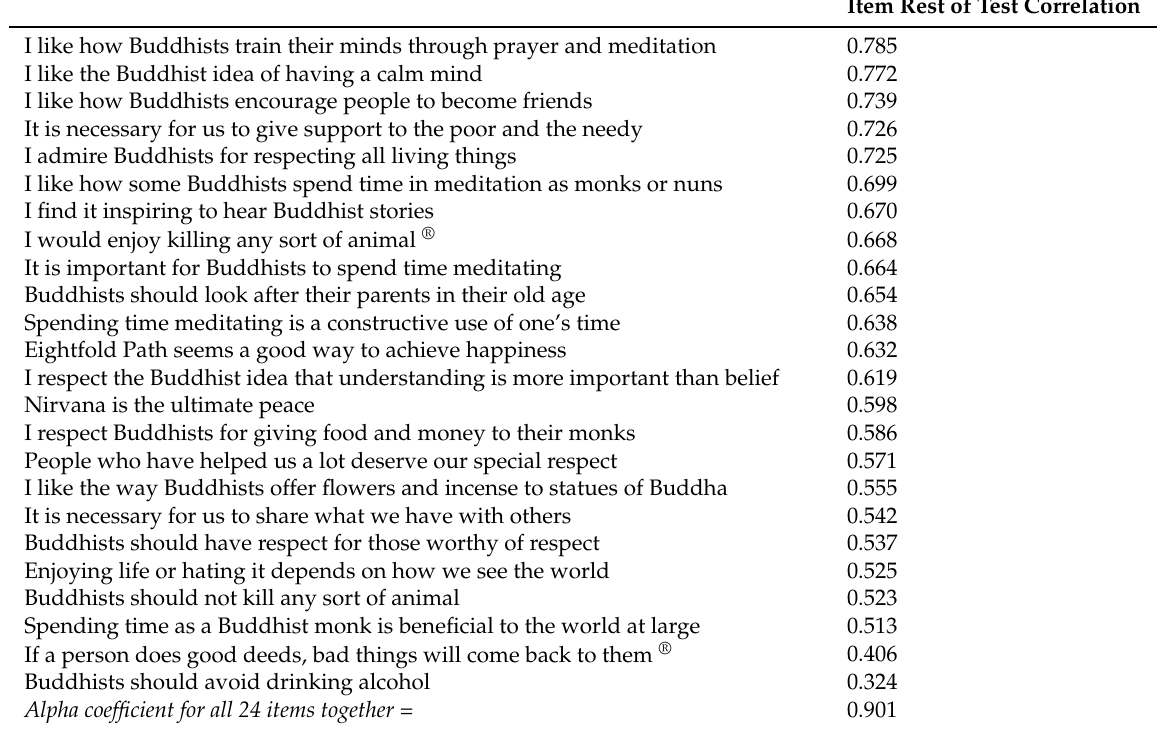
Table 2. Reliability of the revised Scale of Attitude towards Buddhism